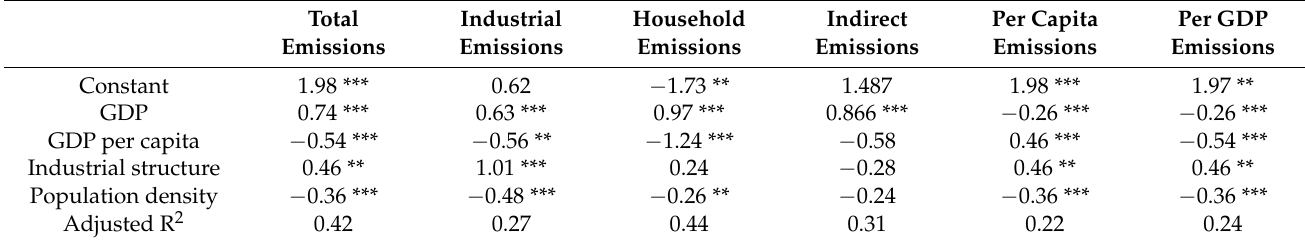
Table 1. Linear regression models for CO 2 emissions and emission